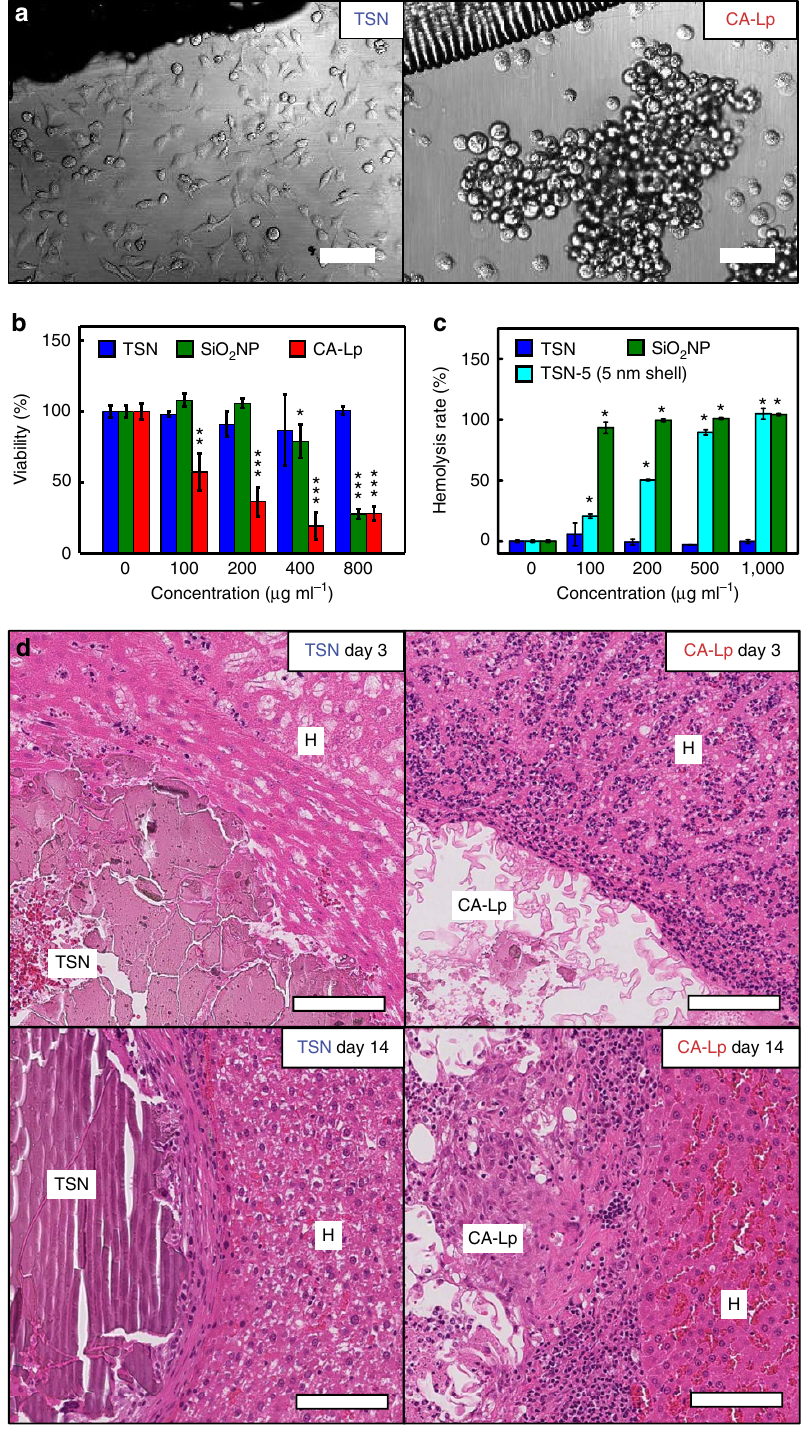
Figure 4 | Evaluation of in vitro and in vivo biocompatibility of TSNs. ( a ) Cellular morphology of mammalian cells (HeLa cell line) incubated with TSNs or CA-Lp. Scale bar indicates 200 m m. ( b ) Viability of cells treated with TSNs, SiO 2 NPs, and CA-Lp. (Data are shown as mean ± s.d., n ¼ 3, * P o 0.05, ** P o 0.01, *** P o 0.001, two-way ANOVA test.) ( c ) Concentration-dependent hemolysis rate of TSNs, SiO 2 NPs, and TSN-5 with 5nm-thick silica. (Data are shown as mean ± s.d., n ¼ 3, * P o 0.001, two-way ANOVA test.) ( d ) Histological analyses for biocompatibility of CA-Lp and TSN. Rat livers were explanted 3 and 14 days after the hemostasis of a puncture model, and the puncture site and adjacent liver tissue were stained with hematoxylin and eosin (H&E). At both 3 and 14 days after TSN injection, the immune cells (purple dots) were scarcely recruited while numerous immune cells accumulated around the puncture site and in the sinusoids among the hepatocytes (H) at both 3 and 14 days after CA-Lp injection. Scale bar indicates 100 m